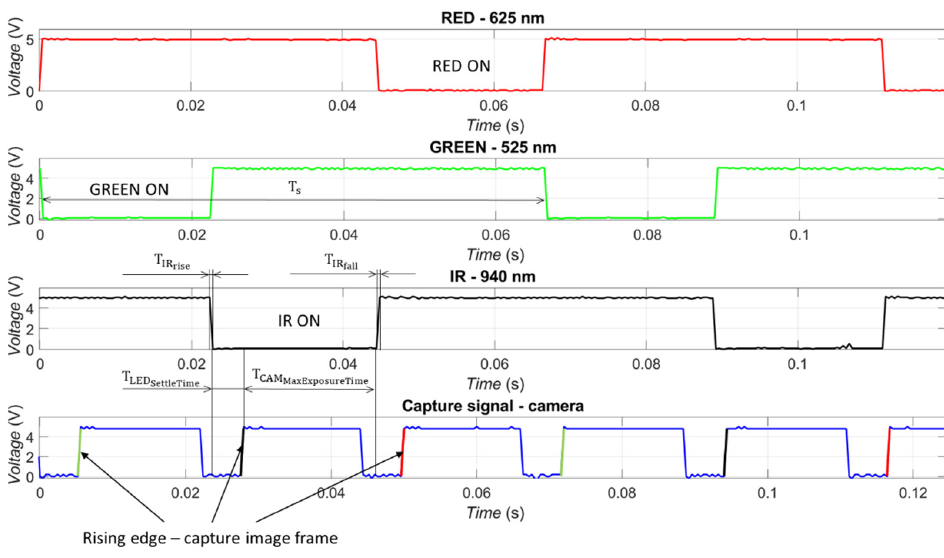
Figure 13. Timing diagram of the proposed system, capture signal (blue color), enable signal of LEDs with wavelength of 625 nm (red color), enable signal of LEDs with wavelength of 525 nm (green color), enable signal of LEDs with wavelength of 940 nm (black color).